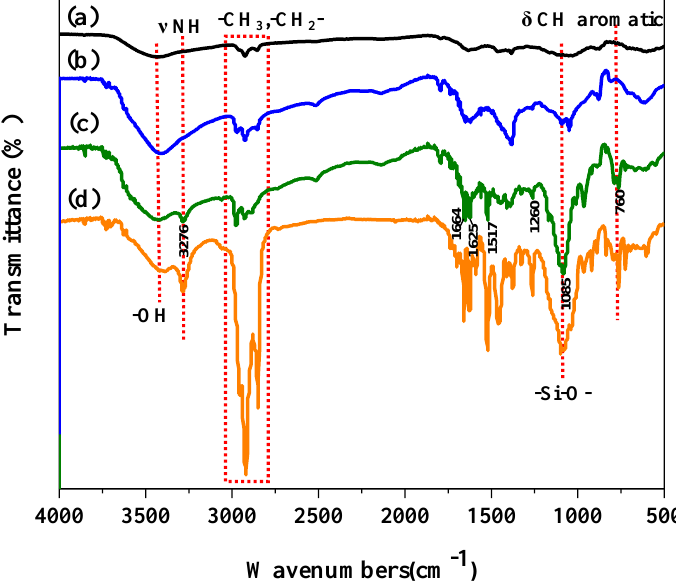
Figure 4. FTIR spectra of raw aluminum pigments ( a ), Al@SiO 2 ( b ), Al@SiO 2 @PFMV ( c ), and PFMV ( d ).